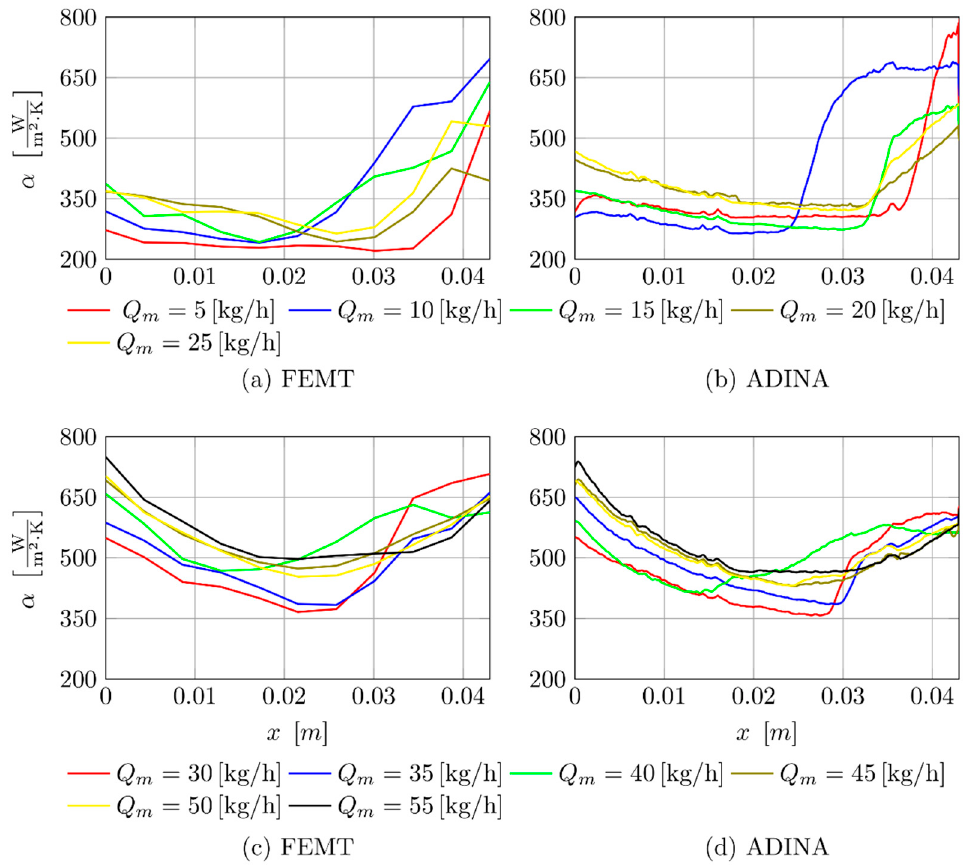
Figure 6. The heat transfer coefficient versus coordinate x along the length of the minichannel determined using Trefftz functions and with the aid of ADINA software, the results obtained for several values of mass flow rate Q m : ( a , b ) 5 [ kg/h ] , 10 [ kg/h ] ,15 [ kg/h ] , 20 [ kg/h ] and 25 [ kg/h ] and ( c , d ) 30 [ kg/h ] , 35 [ kg/h ] , 40 [ kg/h ] ,45 [ kg/h ] , 50 [ kg/h ] and 55 [ kg/h ] . The data corresponding to ONB points are indicated by black arrows in Figure 4.